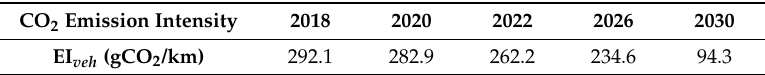
Table 15. Urban bus CO 2 emission intensity to the scenario DG2030.